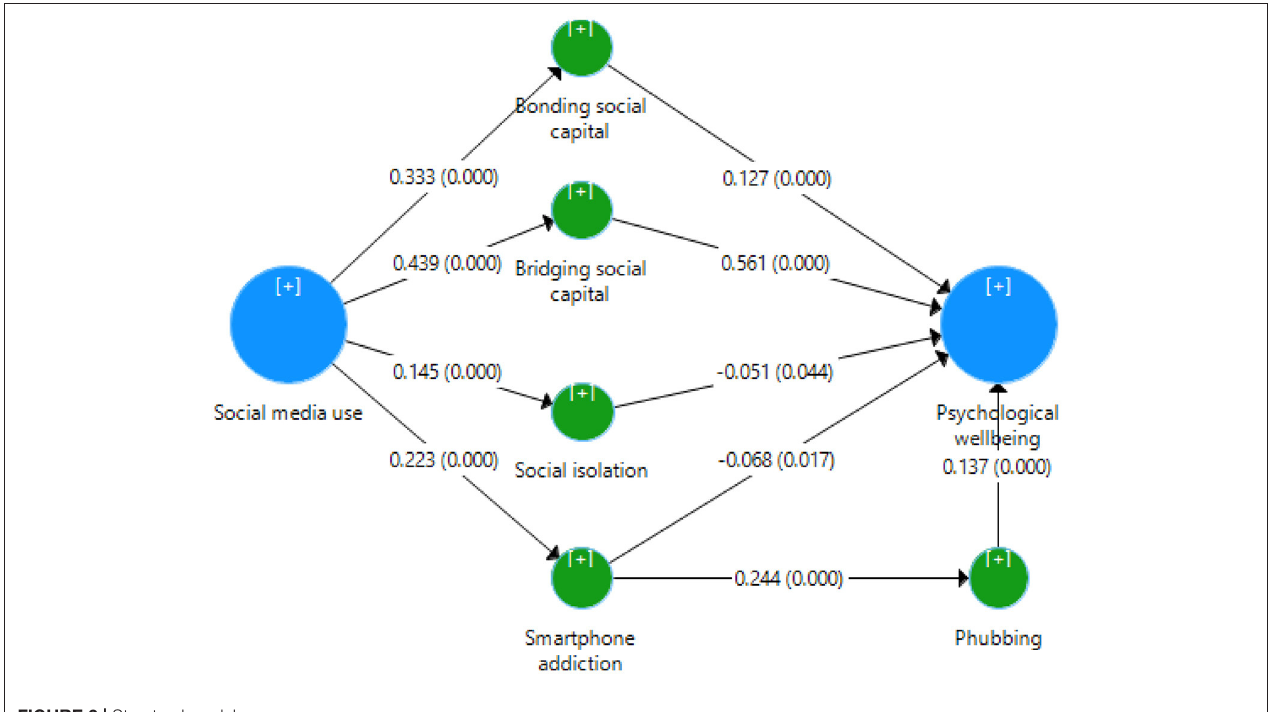
FIGURE 2 | Structural model.